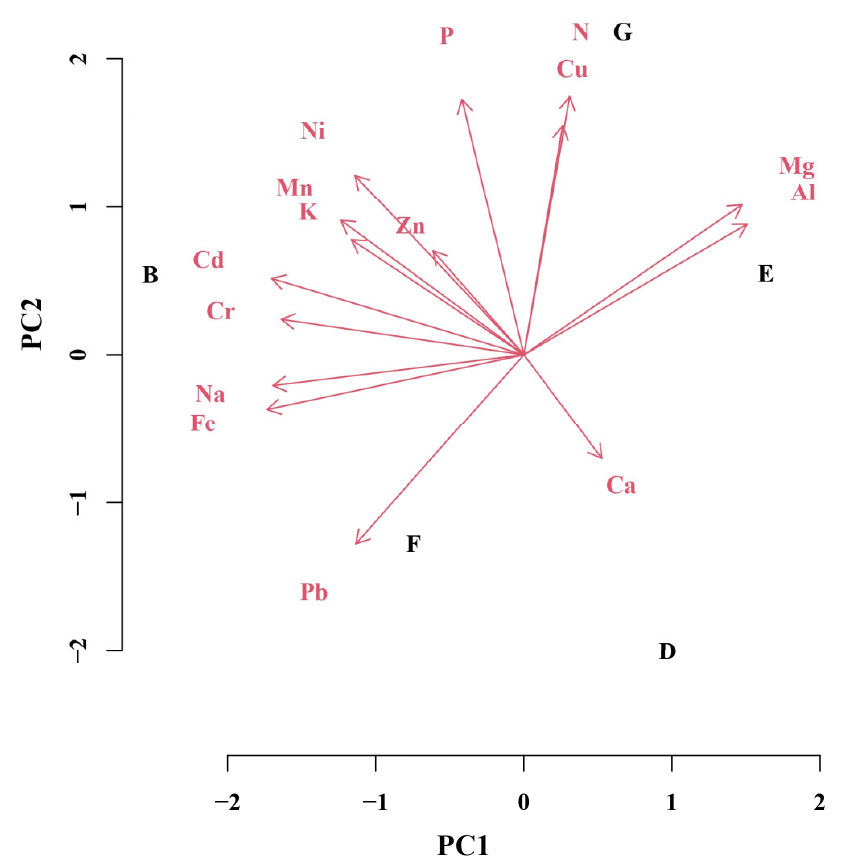
Figure 5. Principal component analysis for the first two principal components of a model testing variation of J. communis habitats depending on the concentration of macroelements (N, Ca, P, K, and Mg), microelements (Mn, Fe, Na, Zn, and Cu), and non-essential elements (Al, Ni, Pb, Cr, and Cd) as variables (red arrows with letters). Black letters denote habitat type: B—coastal brown dunes covered with natural Scots pine forests, F— Juniperus communis scrubs, D—transition mires and quaking bogs, G—subcontinental moss Scots pine forests, and E—xero-thermophile fringes.